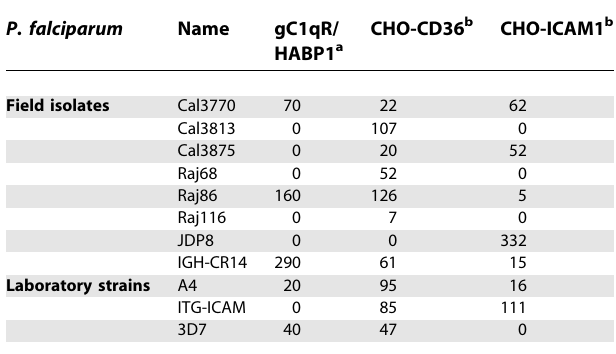
Table 1. Adhesion of P. falciparum Field Isolates and Laboratory Strains to gC1qR/HABP1, CD36, and